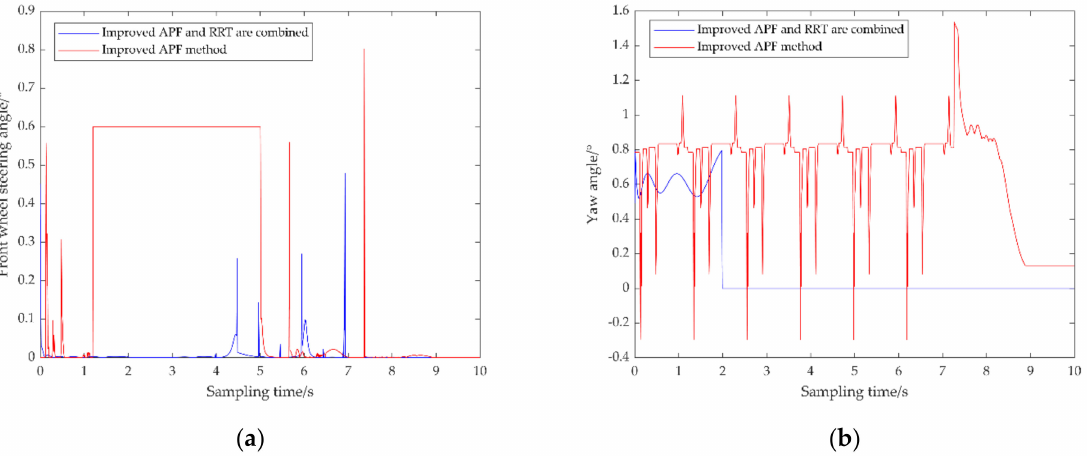
Figure 12. ( a ) Front–wheel steering angle generated by MPC tracking trajectory; ( b ) Yaw angle generated by MPC tracking